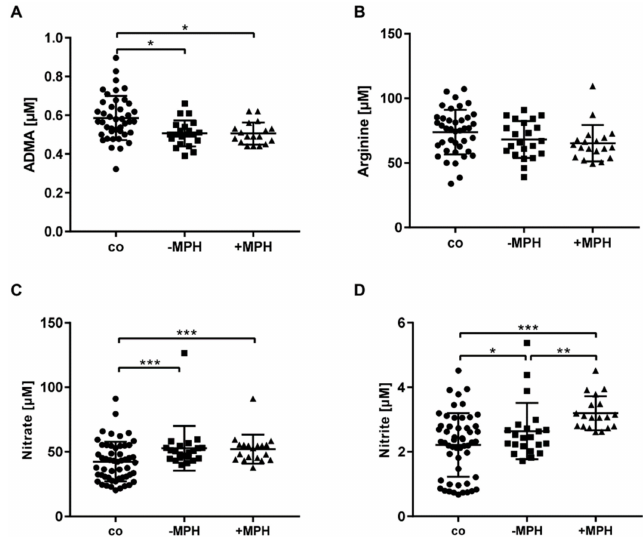
Figure 2. Plasma concentrations of asymmetric dimethylarginine (ADMA) ( A ), arginine ( B ), nitrate ( C ), and nitrite ( D ) of non-ADHD control children (co) and in ADHD children without ( − MPH) and with methylphenidate ( + MPH) treatment. * p < 0.05, ** p < 0.01, *** p <